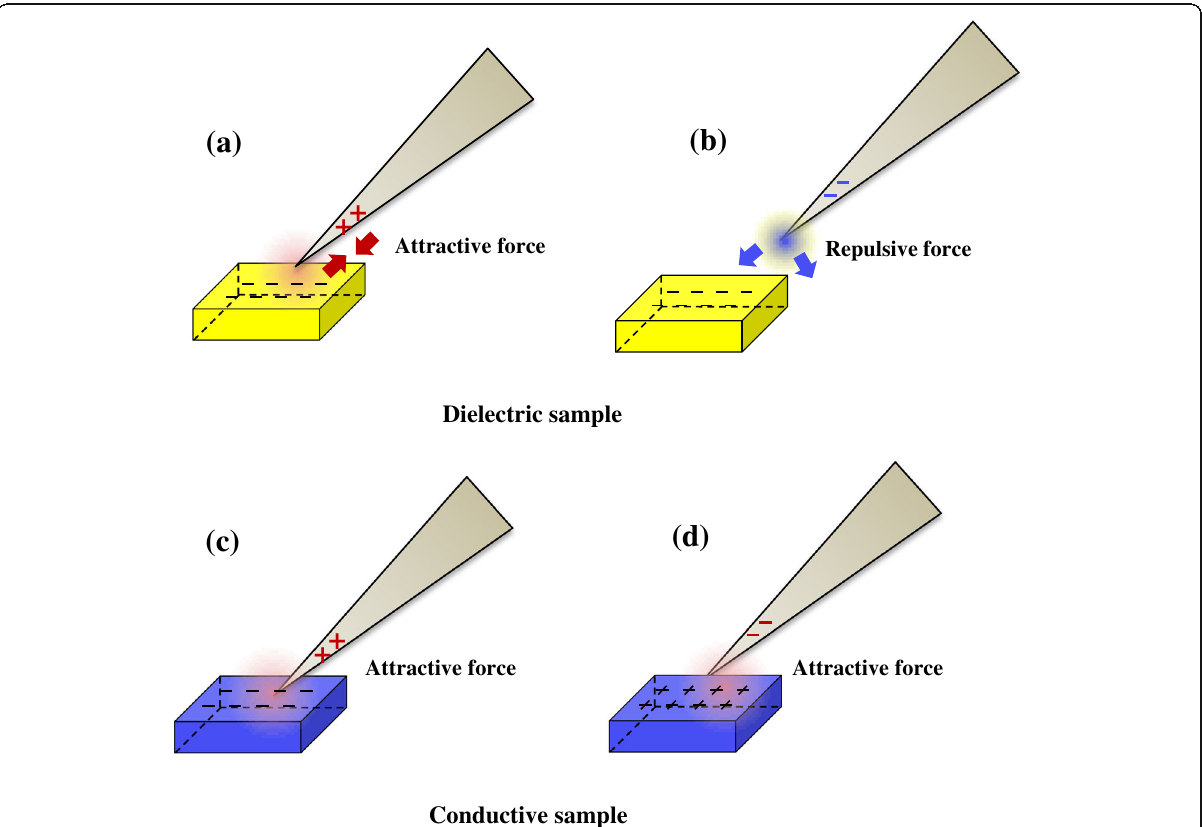
Fig. 2 Schematic illustrations of mechanism of intensifying electrostatic force via biasing on tip ( a - b ) a attractive force induced by positive charge biasing and b repulsive force by negative charge biasing on tip where the surface of dielectric sample has negative charges. c - d Attractive force in conductive specimen induced by both c positive charge biasing and d negative charge biasing on